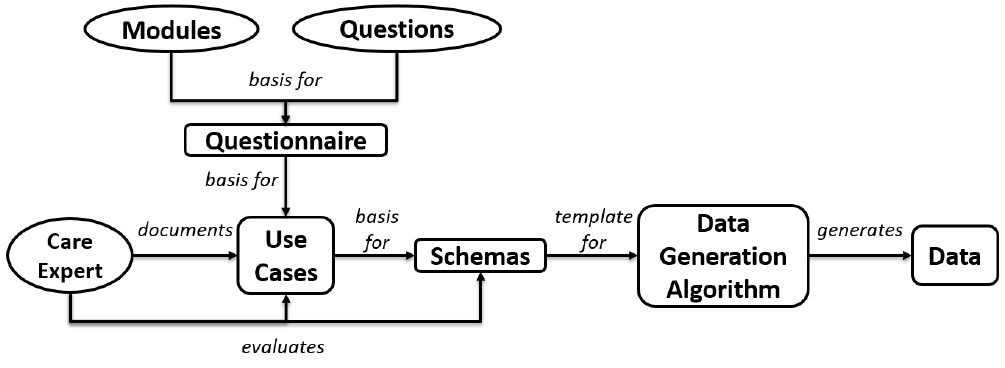
Figure 2. Workflow of Data Generation